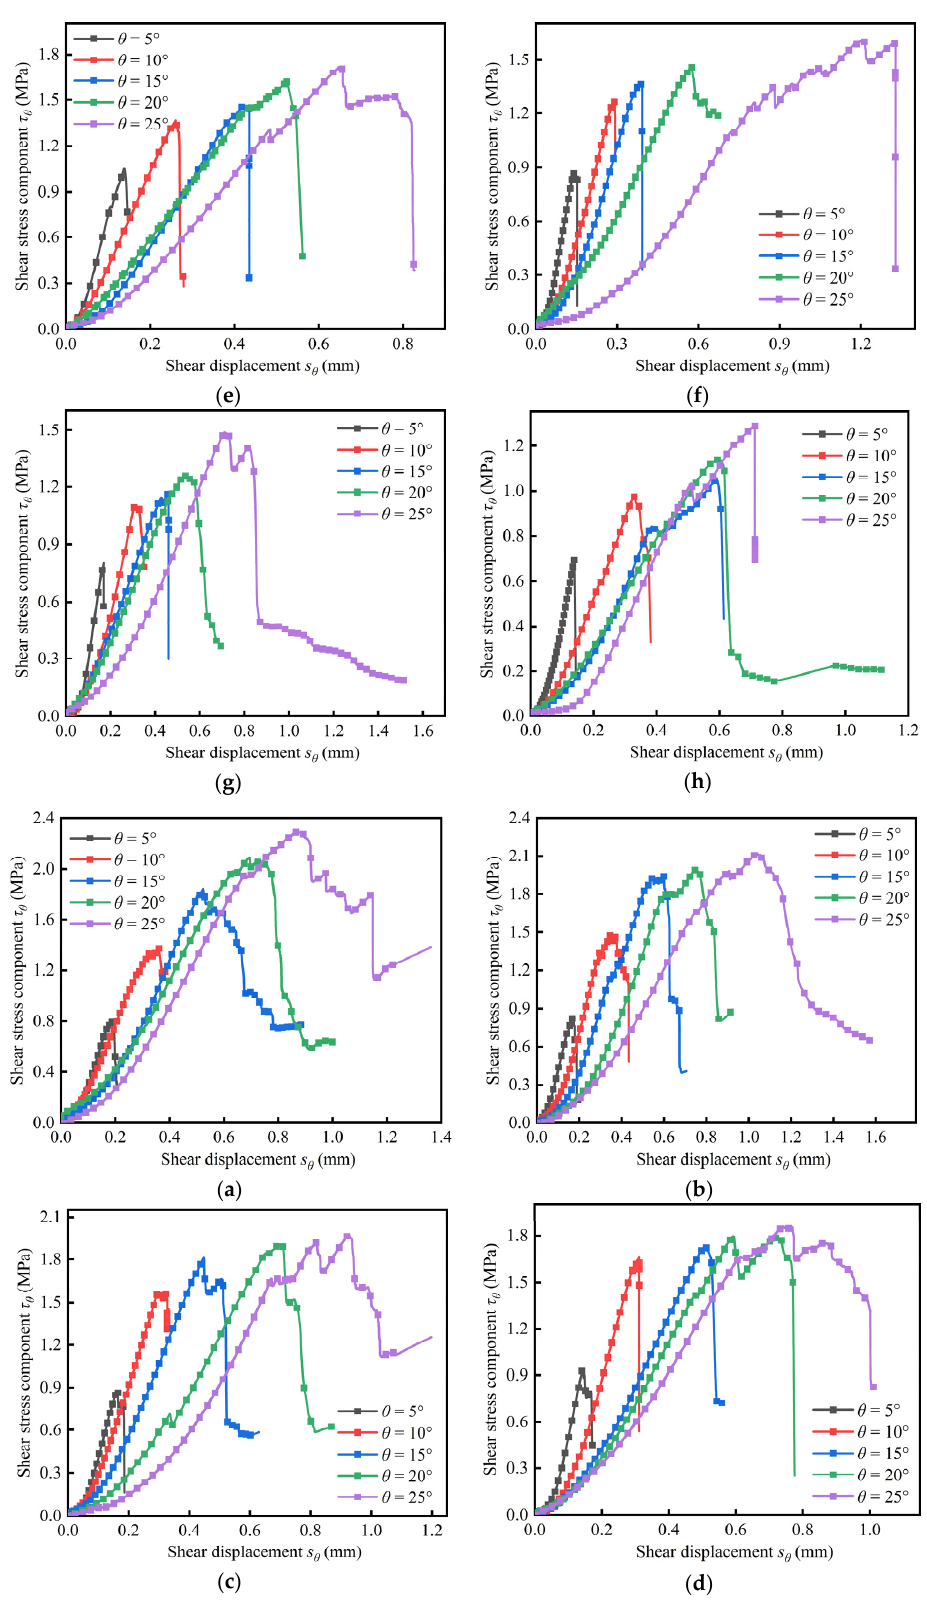
Figure 7. Shear stress component–shear displacement curve under di ff erent loading rates and inclination angles: ( a ) 0.05 mm / min; ( b ) 0.5 mm / min; ( c ) 1.0 mm / min; ( d ) 2.0 mm / min; ( e ) 3.5 mm / min; ( f ) 5.0 mm / min; ( g ) 7.5 mm / min; ( h ) 10.0 mm /